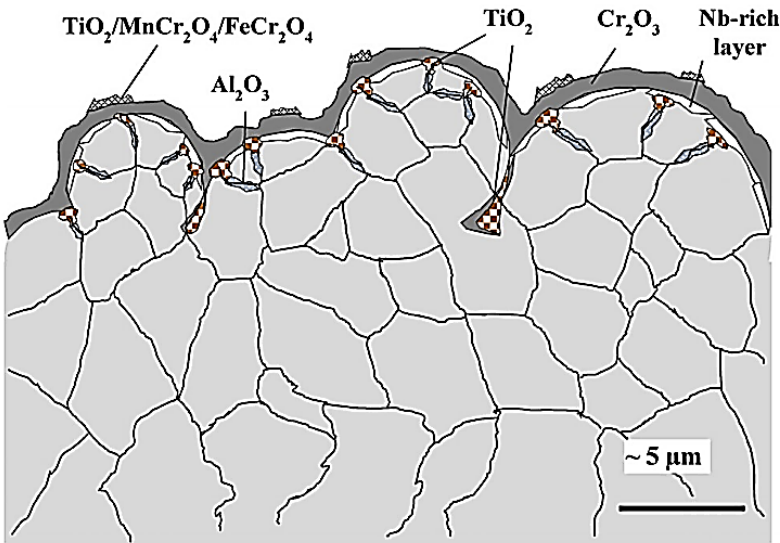
Figure 1. Formation of surface oxides on an additively manufactured IN 718 surface after high-temperature oxidation. Reprinted from Sanviemvongsak et al. [31], Copyright 2018, with permission from Elsevier.